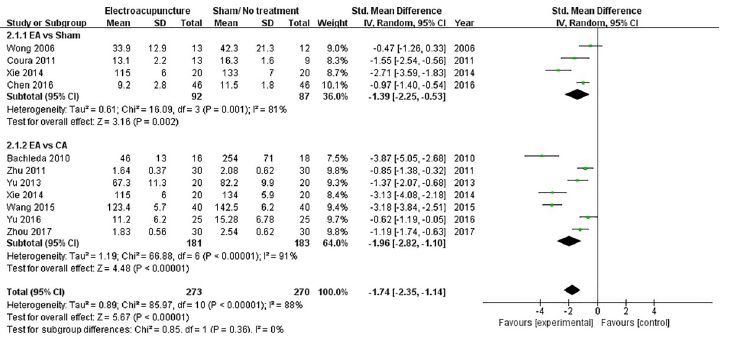
Fig 4. Forest plot of total dose of opioid analgesics before sensitivity analysis.